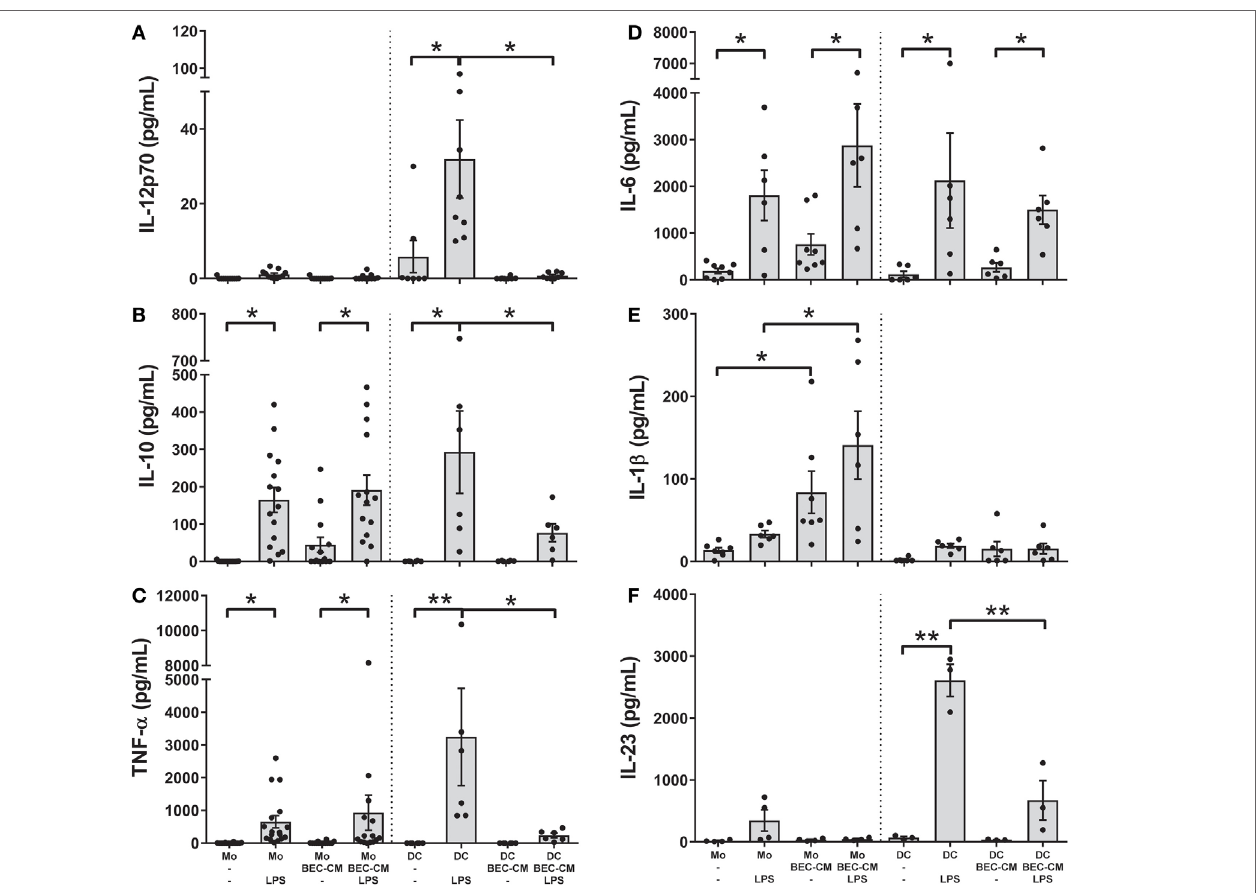
FigUre 5 | Bronchial epithelial cell-conditioned media (Bec-cM) regulates the release of cytokines by monocytes and dendritic cells (Dcs) differentially after lipopolysaccharide (lPs) . Monocytes and DCs were cultured for 48 h with medium alone or with BEC-CM. Cells were stimulated with LPS (100 ng/mL) for the last 24 h. The secretion of cytokines was analyzed using the Luminex system or ELISA: (a) IL-12p70, (B) IL-10, (c) TNF- α , (D) IL-6, (e) IL-1 β , and (F) IL-23. Data are expressed as means ± SEM of at least four independent experiments. Statistical analysis was performed using analysis of variance test (followed by the Fisher LSD test) (* P < 0.05, ** P <